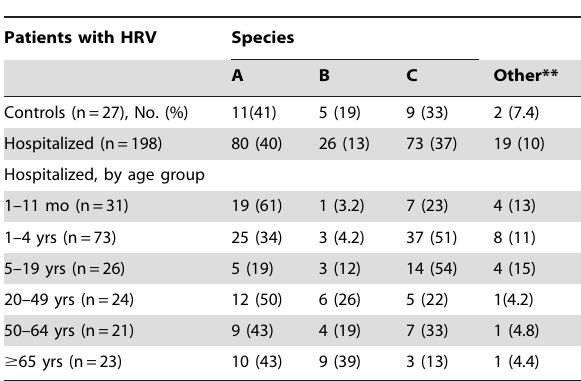
Table 4. HRV species identified among hospitalized enrolled patients and controls £ , Sa Kaeo province, Thailand, September 1, 2004–August 31, 2005 (n =229).